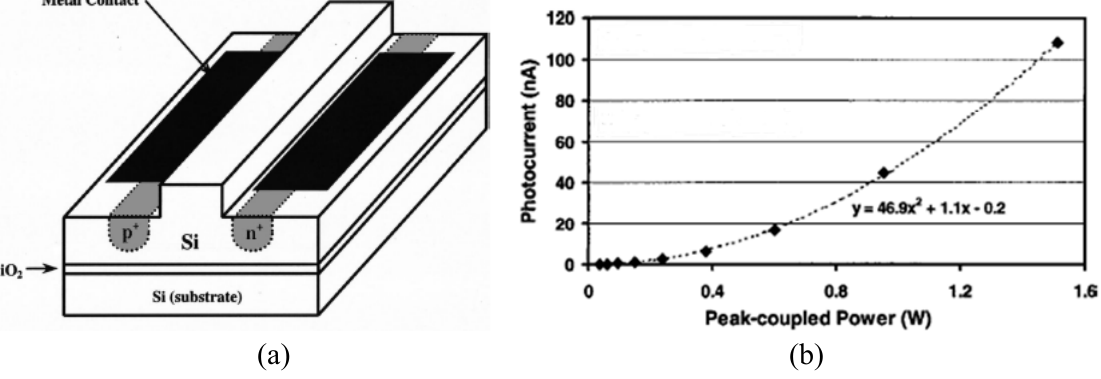
Figure 18. Sketch (a) and measured photocurrent (b) of the TPA-based detector proposed by Liang et al. [75]. Reprinted with permission from T.K. Liang, et al. , Copyright 2002, American Institute of Physics.